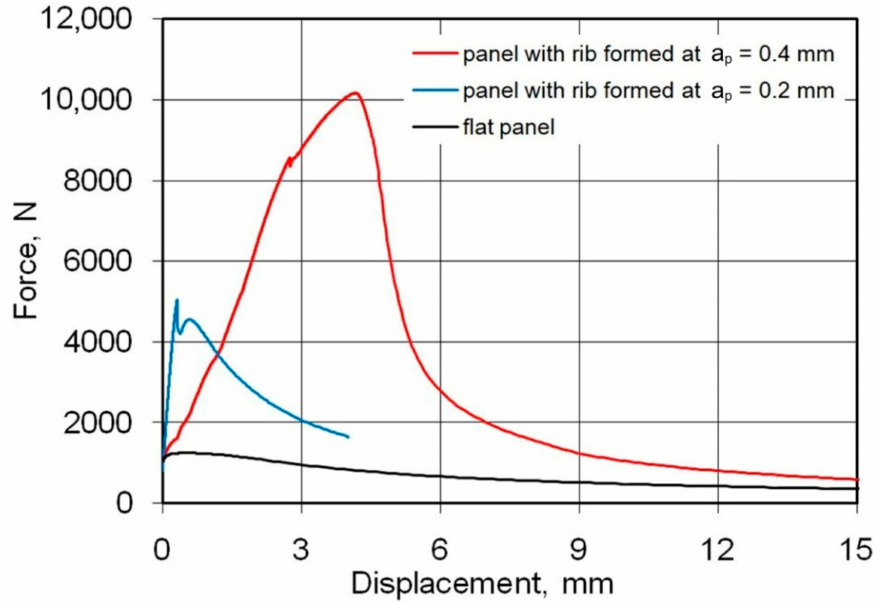
Figure 13. Load-displacement curves of the panels fabricated from 1-mm-thick EN AW-2024-T3 panels subjected to compression